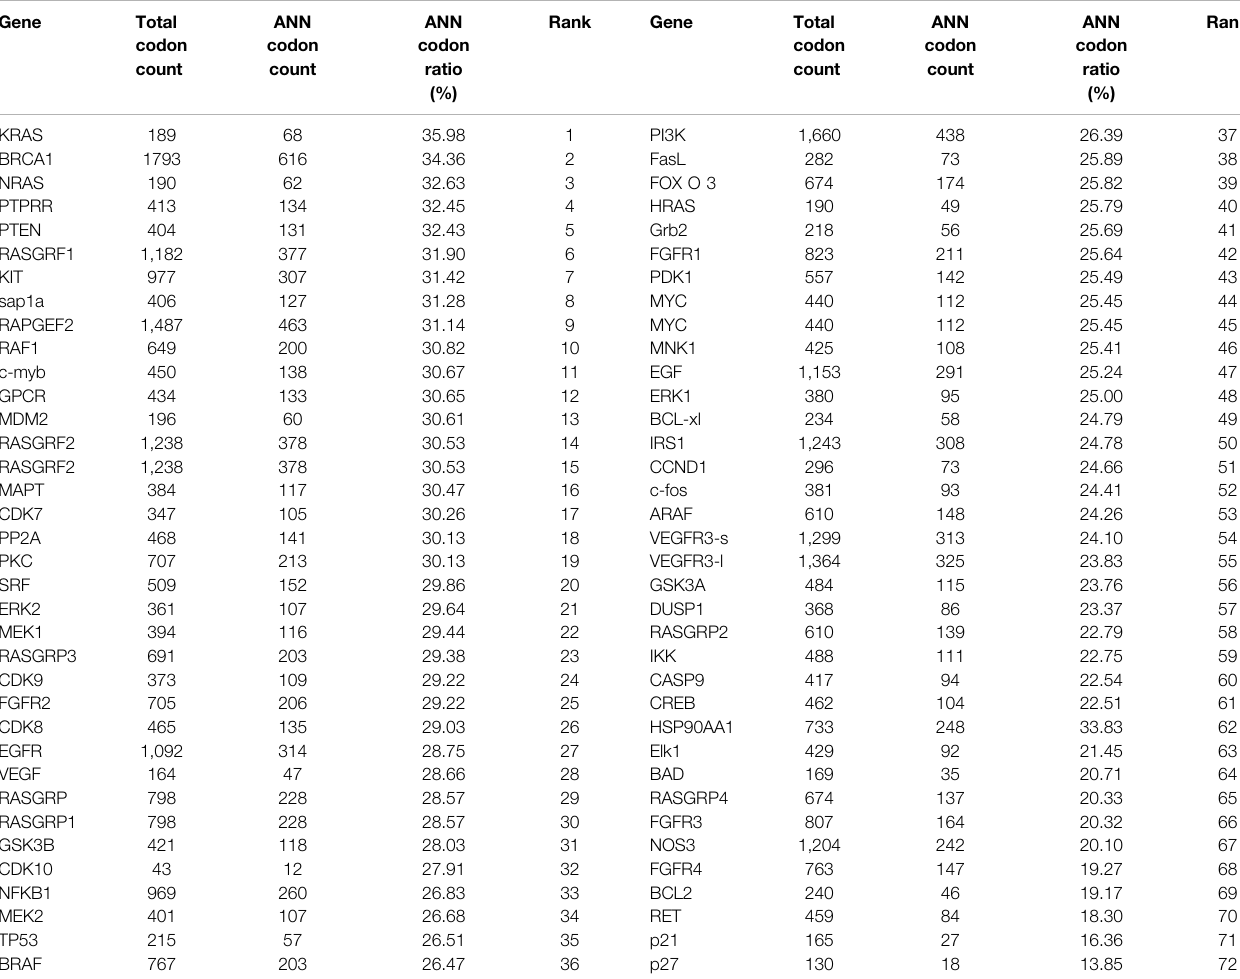
TABLE 1 | The codon composition of all genes related in the lenvatinib antitumor pathway.